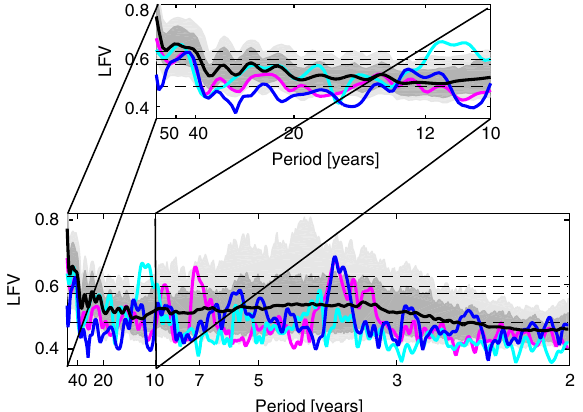
Fig. 2 Spectra for the global surface temperature fi elds from historical CMIP5 simulations using natural and anthropogenic forcing and historical observations. Shading with mean over all model simulations is shown by black curve and historical result is shown by blue curve. The HadGEM2-ES (purple) and MPI-ESM-LR (cyan) simulations are shown for comparison. Lower ( f = 0.015 cycle/year) and upper ( f = 0.5 cycle/year) bound on frequencies shown correspond to edge of secular band and Nyquist sampling frequency. Inset zooms in on the decadal ( f = 0.1 cycle/ year) and longer periodicities. Horizontal dashed lines correspond to median ( p = 0.5) and p = 0.1, 0.05 and 0.01 signi fi cance levels relative to coloured noise null hypothesis. Local Fractional Variance